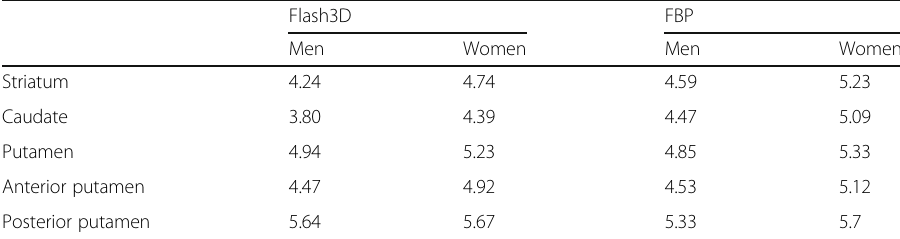
Table 6 Age-related decline in DAT availability (in % per decade)